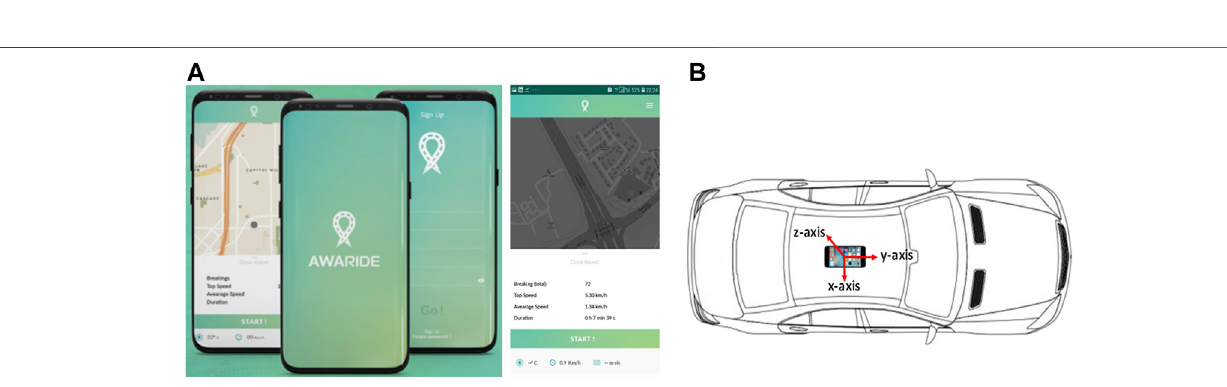
Frontiers in Built Environment |